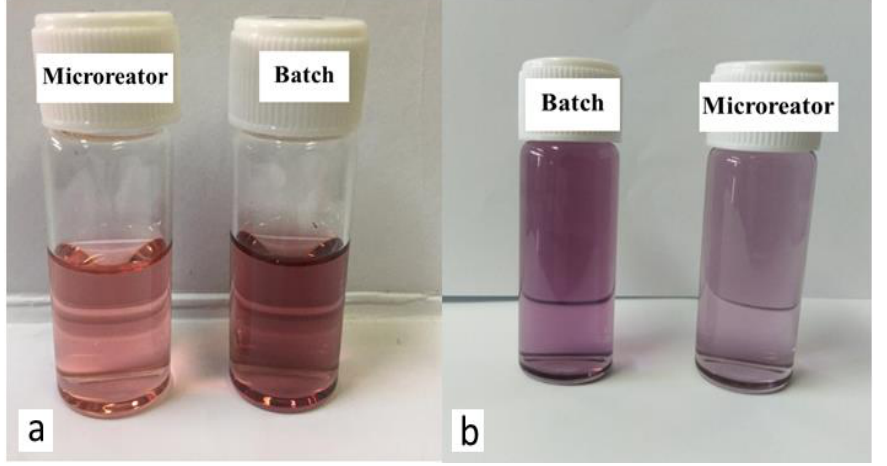
Figure 9. ( a ) Colors for GNPs samples prepared in a microreactor with a HAuCl 4 concentration of 0.7 mM. ( b ) with an initial HAuCl 4 concentration of 2 mM.